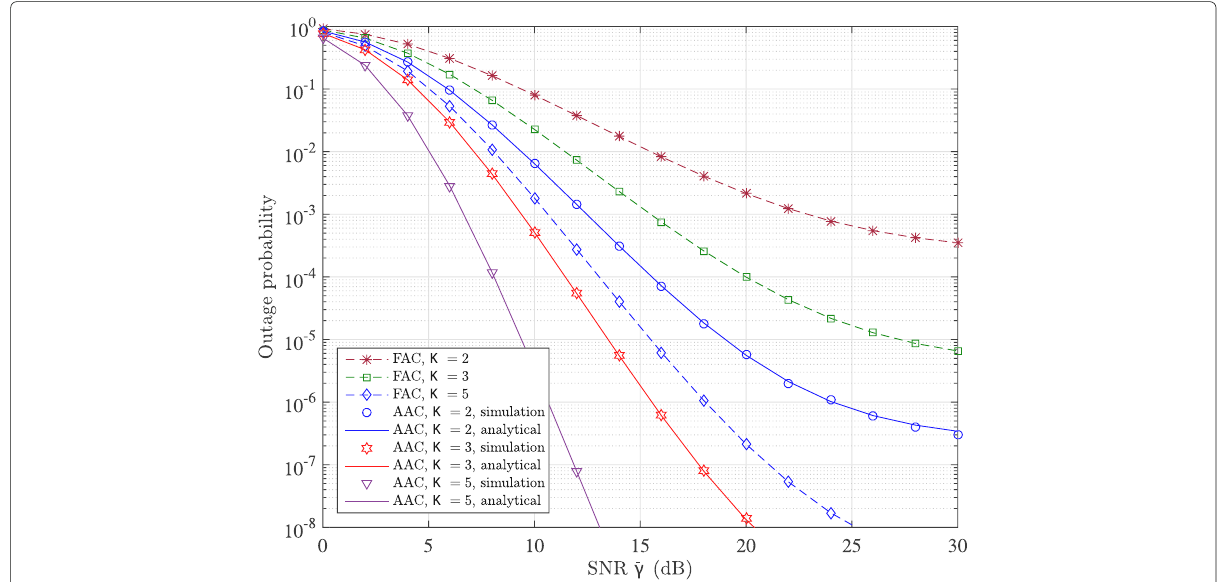
Fig. 3 Outage performance versus transmit power for the FD relay system with different values of K and the self-interference level η =